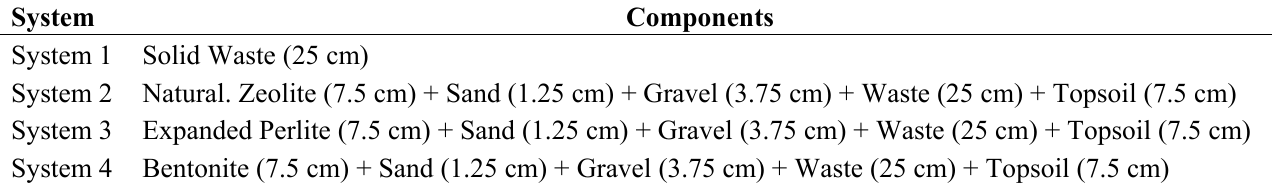
Table 3. Components and their rates in the test